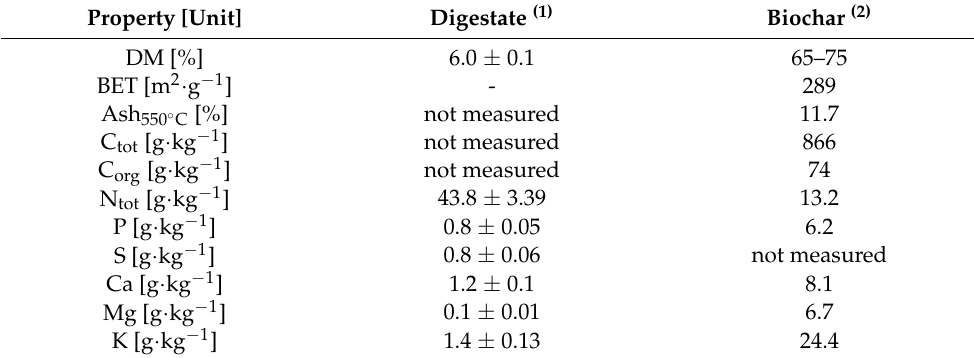
Table 1. Properties of soil amendments.